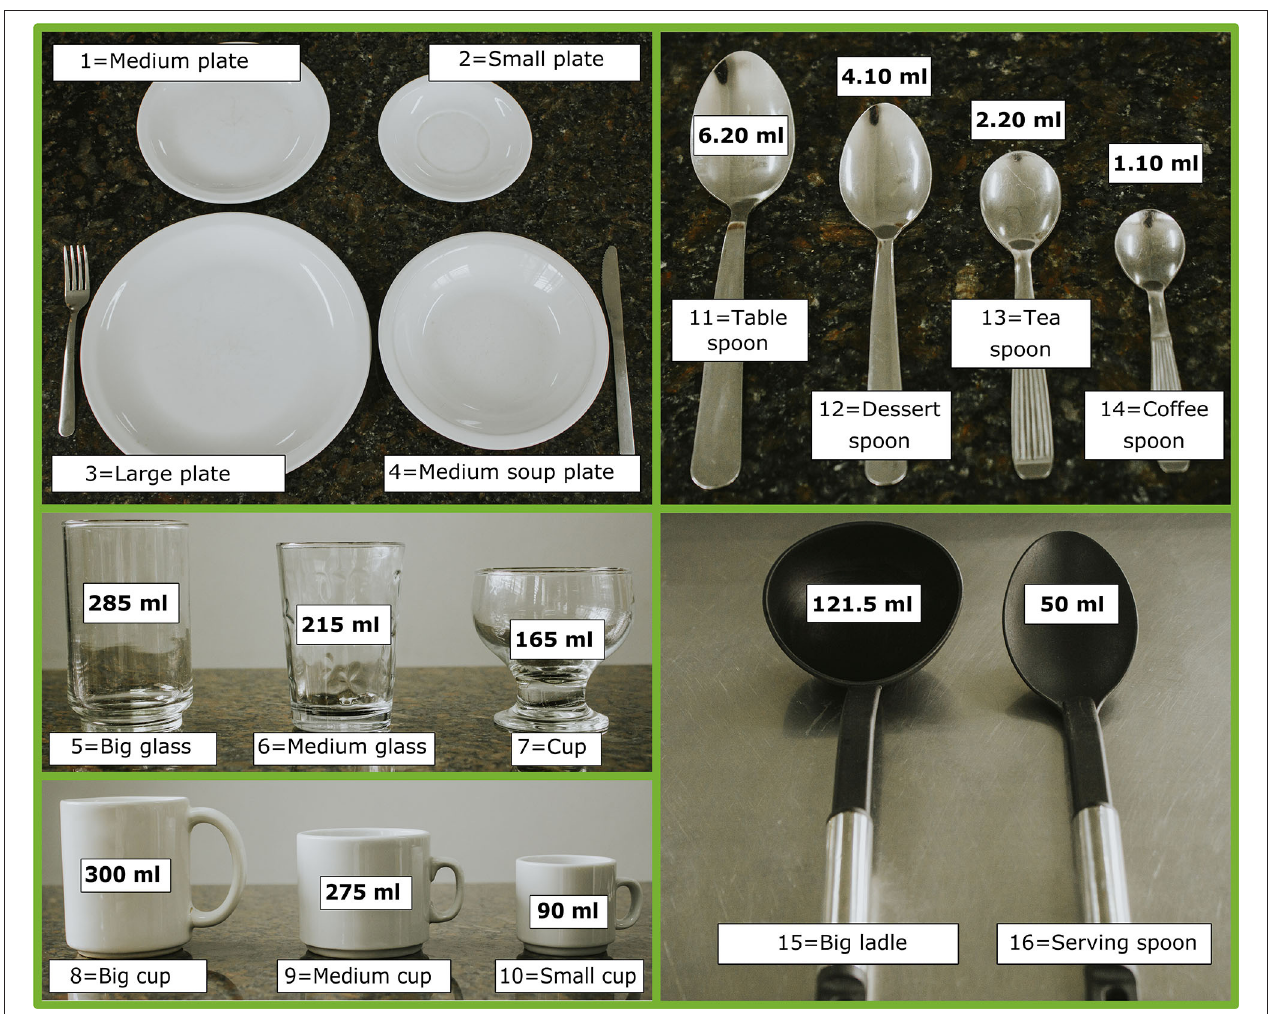
FIGURE 1 | Household measures references of the MAR24 photo